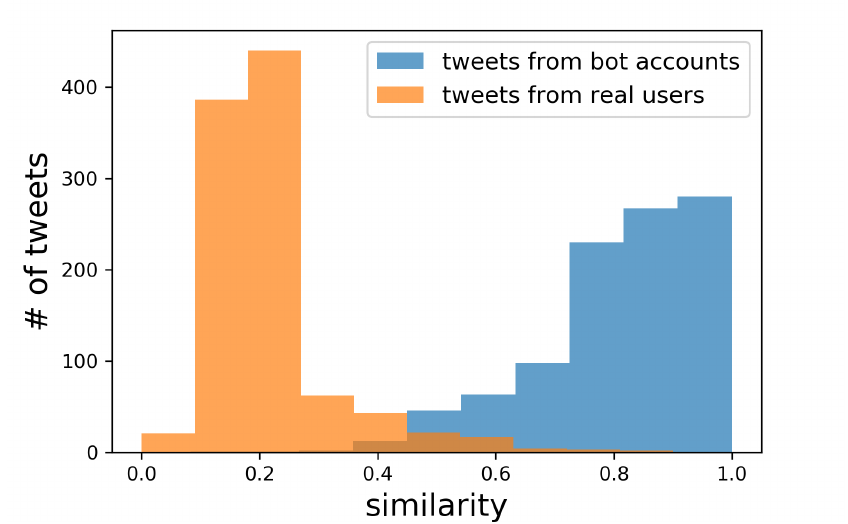
Figure 6. Maximum similarity for tweets from bot accounts and real users. Bot accounts tend to post similar tweets among themselves as shown in Table 1 (with the maximum similarity over 0.4), while real users tend to post unique tweets (with the maximum similarity under 0.4).